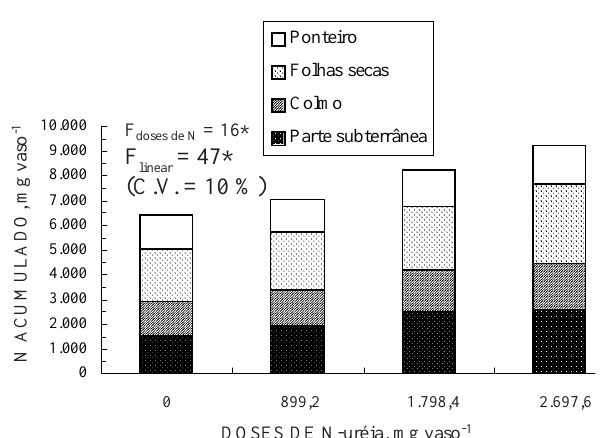
Figura 3. Acúmulo de N na cana-planta em relação às doses de N-uréia aplicadas no plantio (os valores de teste F e de C.V. referem-se à planta